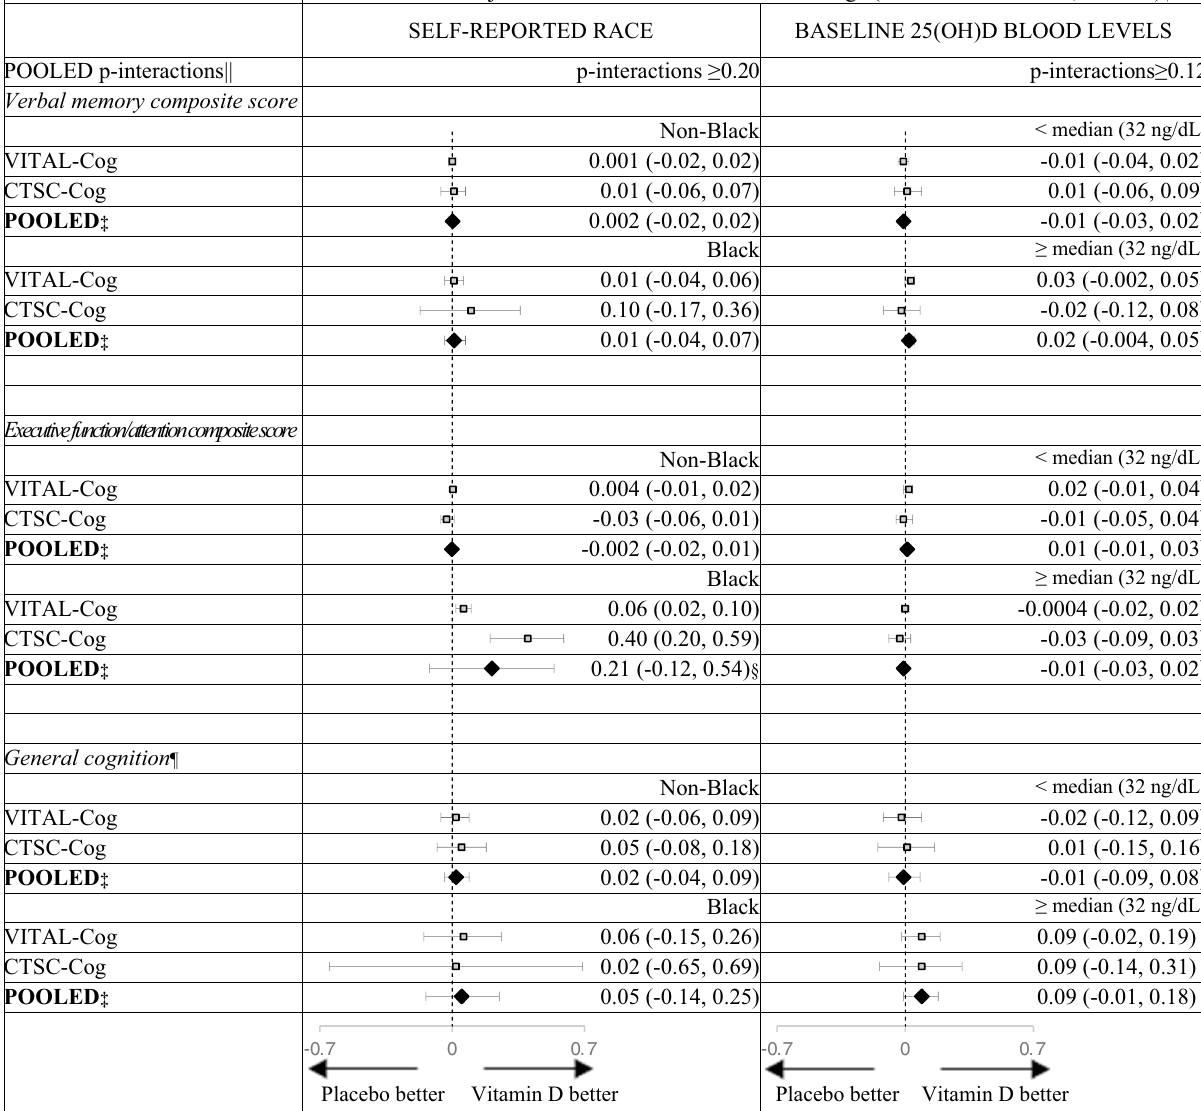
Table 5. Pooled results across VITAL-Cog and CTSC-Cog for mean difference in annual rate for the secondary outcomes for vitamin D-Placebo: effect modification by race and blood 25(OH)D levels for cognitive decline.